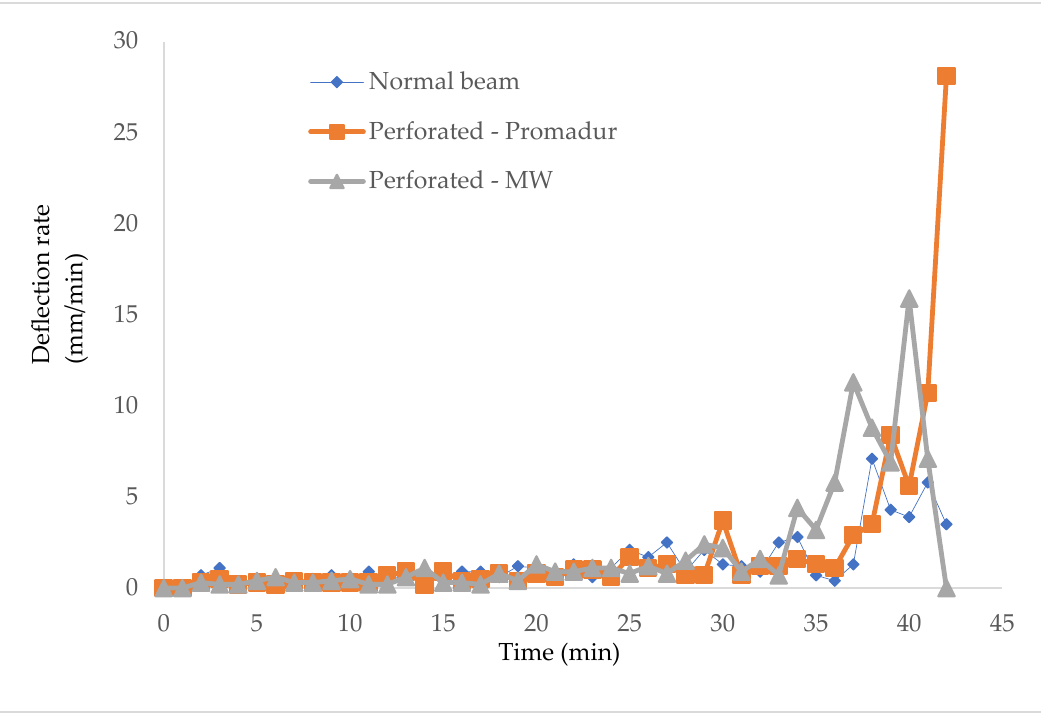
Figure 21. Deflection rate.